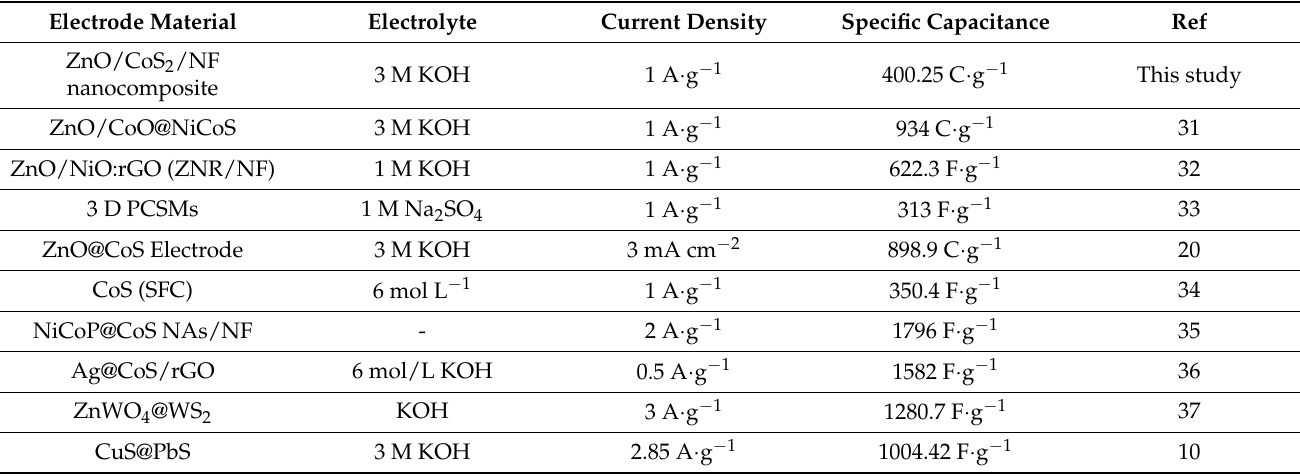
Table 1. Comparison of specific capacitance for various composite electrode materials in aqueous electrolyte as reported in the